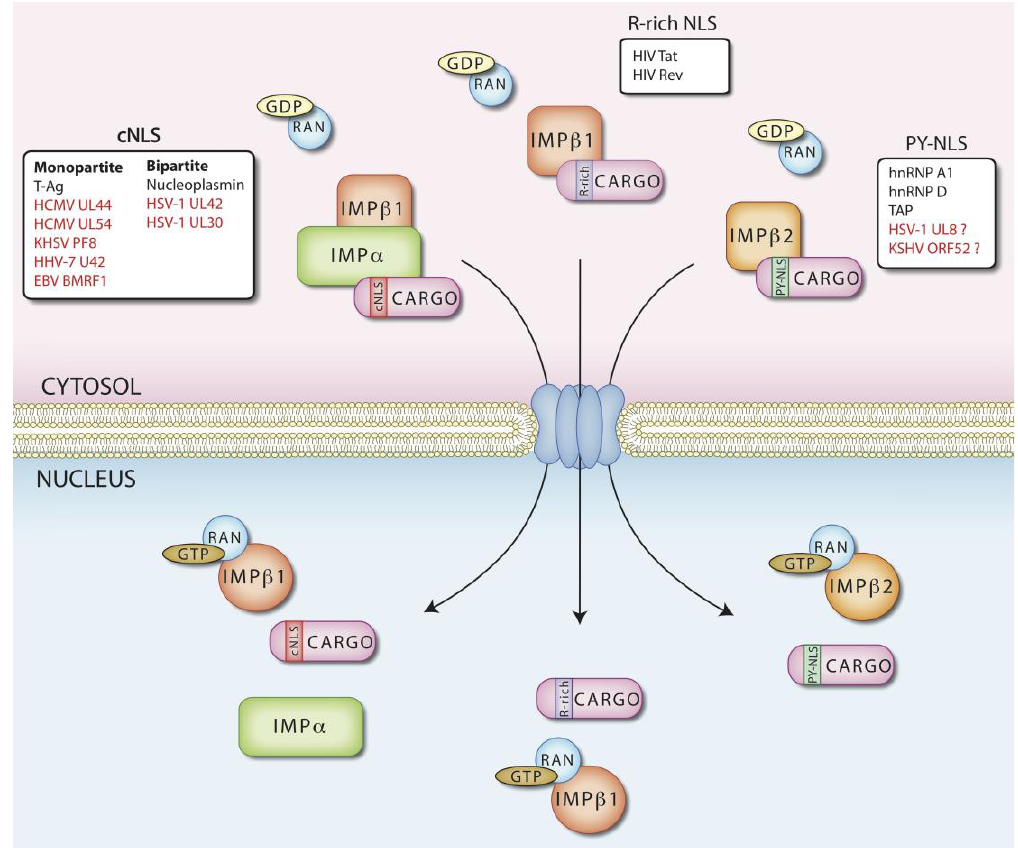
Figure 1. Cellular transporters involved in signal dependent nuclear targeting of herpesviral proteins. Transport of cargoes across the nuclear envelope (NE)